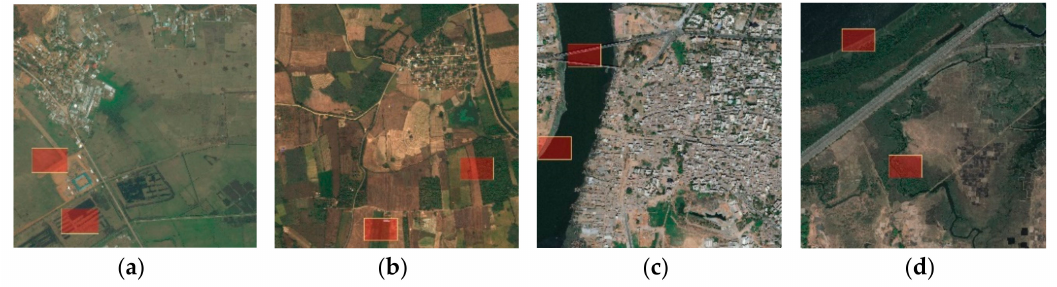
Figure 2. Sampled satellite images from the DeepGlobe Land Cover dataset with two selected 324 × 220 regions that are highlighted in red and are used for our dataset: ( a ) “676758_sat.jpg,“ ( b ) “762359_sat.jpg,“ ( c ) “941237_sat.jpg,“ ( d ) “668465_sat.jpg.“ Names of images from our constructed dataset [23] share the same < ID’s > in part1 and part2 folders.